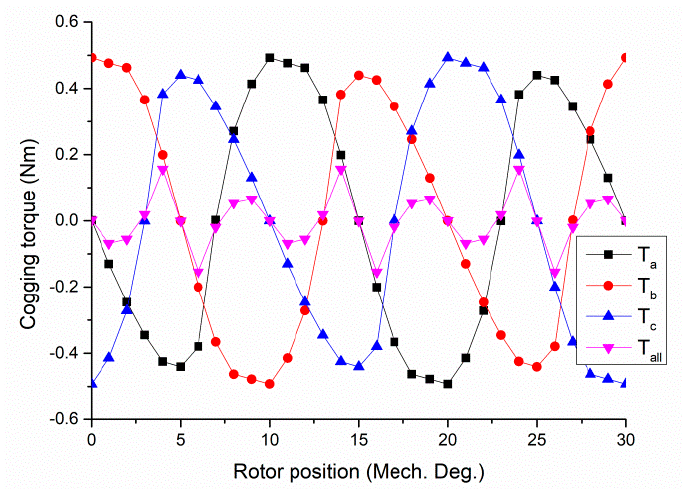
Figure 7. Cogging torque of FRCPM.